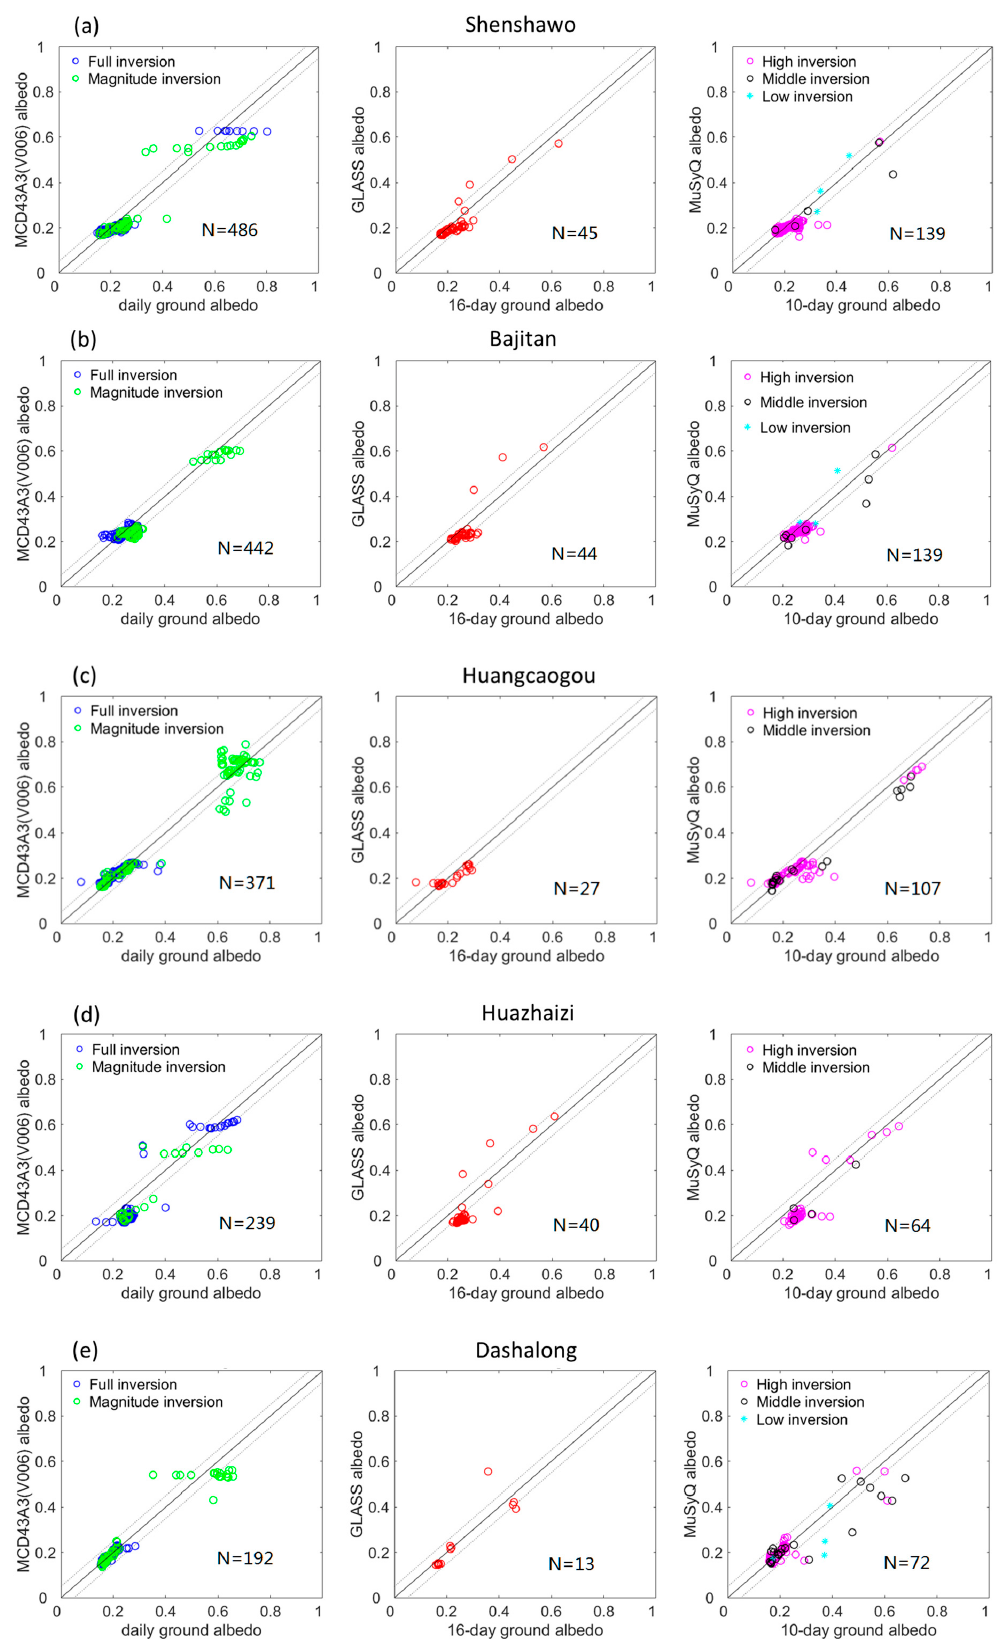
Figure A1. Frequency distribution histogram and cumulative frequency of representativeness errors of ground sites with respect to the 500 m and 1 km pixel scale albedos.